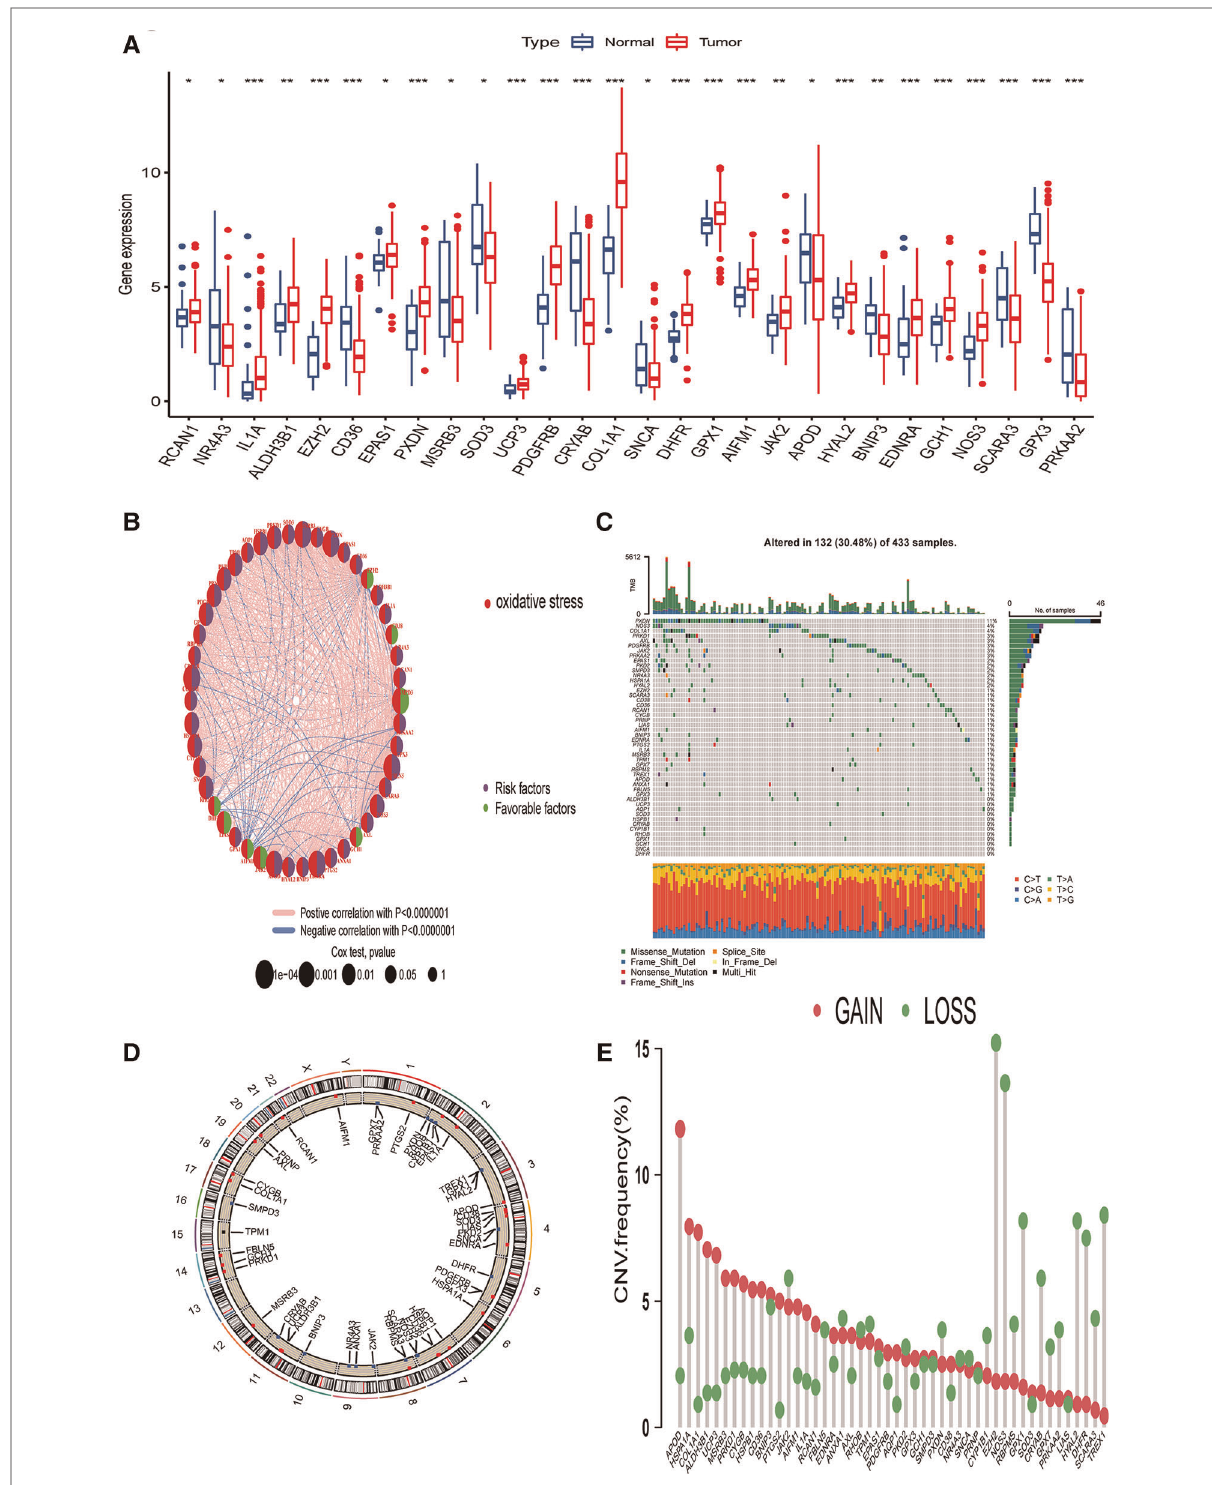
FIGURE 1 Genetic changes and ORGs gene expression in STAD. ( A ) Differentially expressed genes of ORGs in STAD issues and Normal tissues. ( B ) Interaction relationship of 48 ORGs in STAD. ( C ) Mutation type and mutation frequency of ORGs in STAD. ( D ) The location of ORGs in chromosomes. ( E ) The change of CNV of ORGs in the STAD cohort. ORGs, oxidative stress-related genes; STAD, stomach adenocarcinoma; CNV, copy number